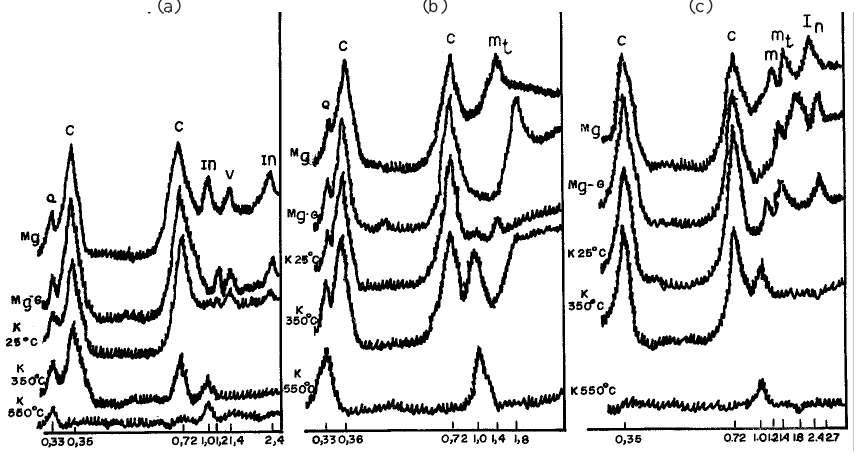
Figura 3. Difratogramas da fração argila do perfil 9 (SXen). (a) horizonte Ap; (b) horizonte 2Btn e (c) horizonte 2Cr2. Q: quartzo; C: caulinita; V: vermiculita;In: interestratificado; Mt: montmorilonita. Valores de d/n em nanômetros.